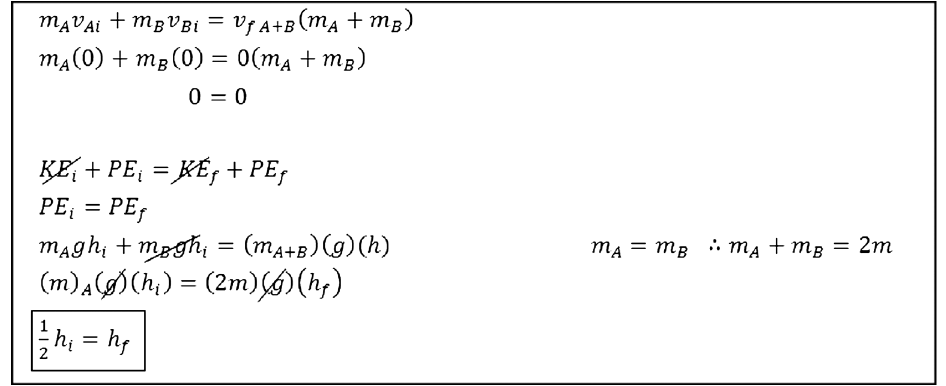
FIG. 4. Example solution by a student who applied the CM principle to an incorrect situation.